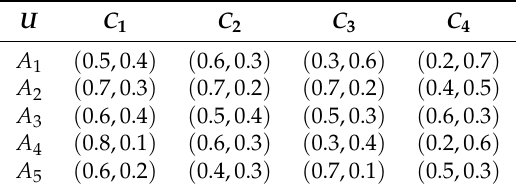
Table 2. Intuitionistic fuzzy soft set I = ( (cid:101) F , C )